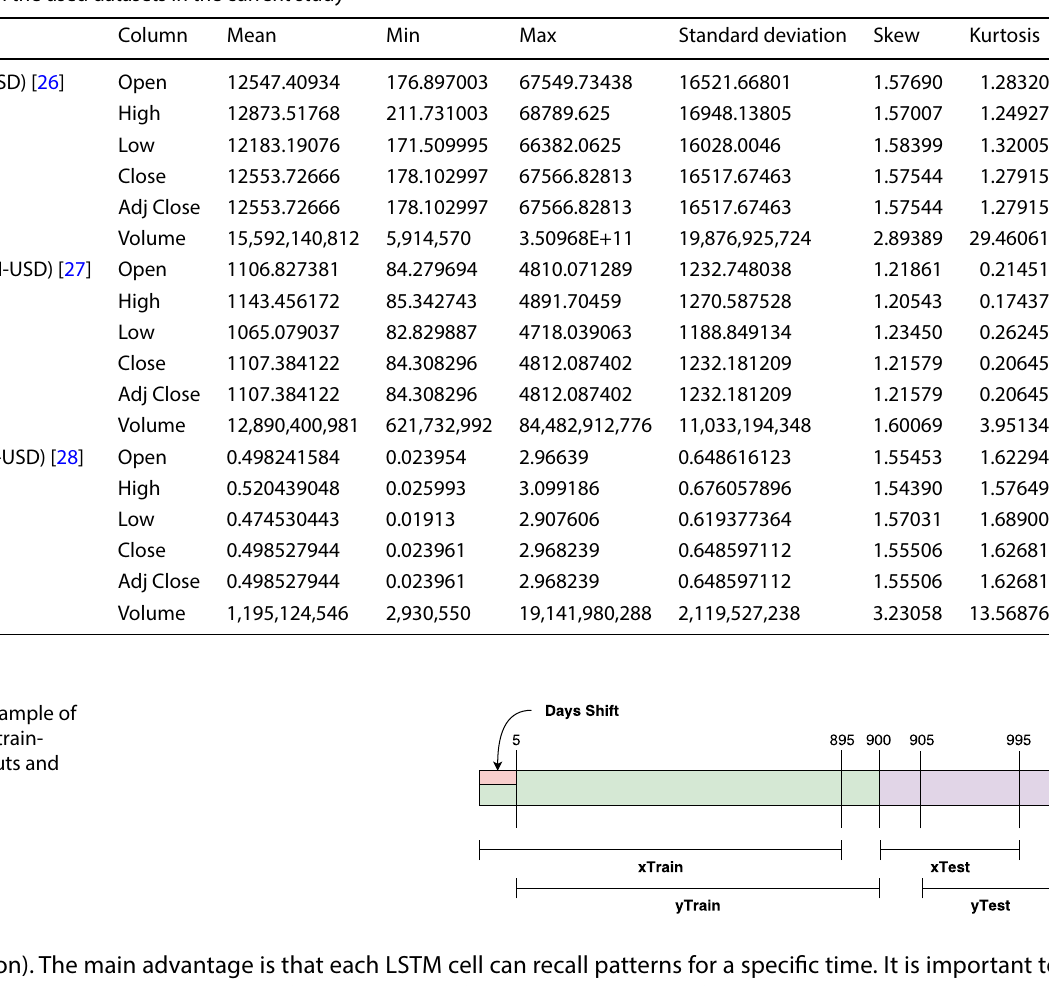
Table 3 Statistics on the used datasets in the current study Dataset